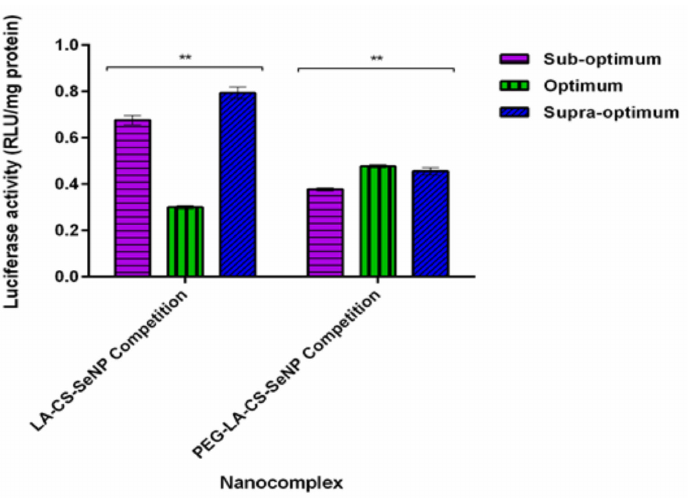
Figure 10. In vitro transfection potential of hepatocellular targeted FSeNPs after blocking of the ASGPR in the receptor competition binding assay in the HepG2 cells. Data are represented as mean ± SD ( n = 3): ** p < 0.01 showing a statistical significance between similar ratios using two-way